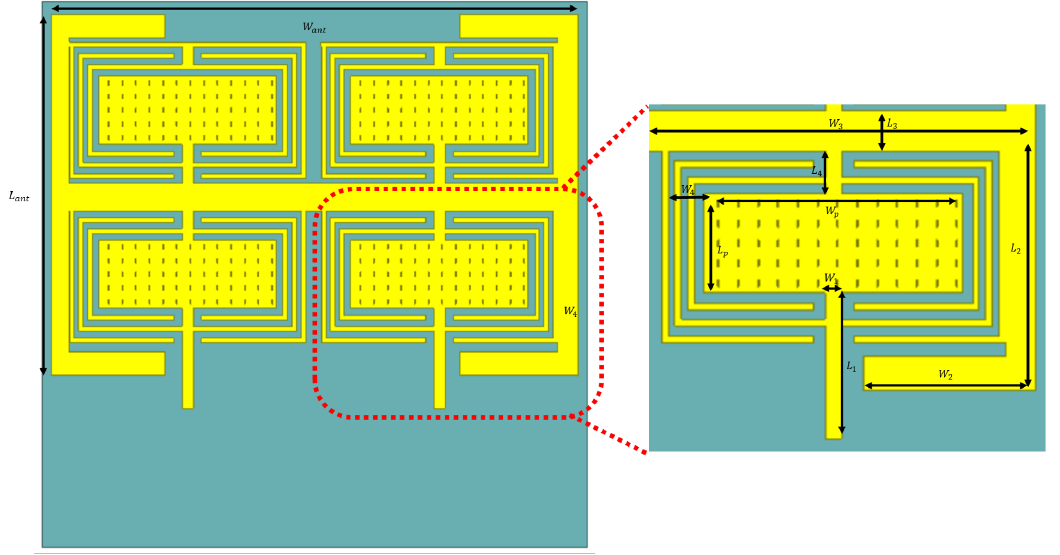
Figure 10. Antenna body with symmetrical square metal ring (The parameters are: L ant = 760 µ m, W ant = 1145 µ m, W 1 = 25 µ m, W 2 = 250 µ m, W 3 = 575 µ m, W 4 = 55 µ m, L 1 = 210 µ m, L 2 = 345 µ m, L 3 = 60 µ m, L 4 = 64.5 µ m, and metal ring fine wire diameter = 10 µ